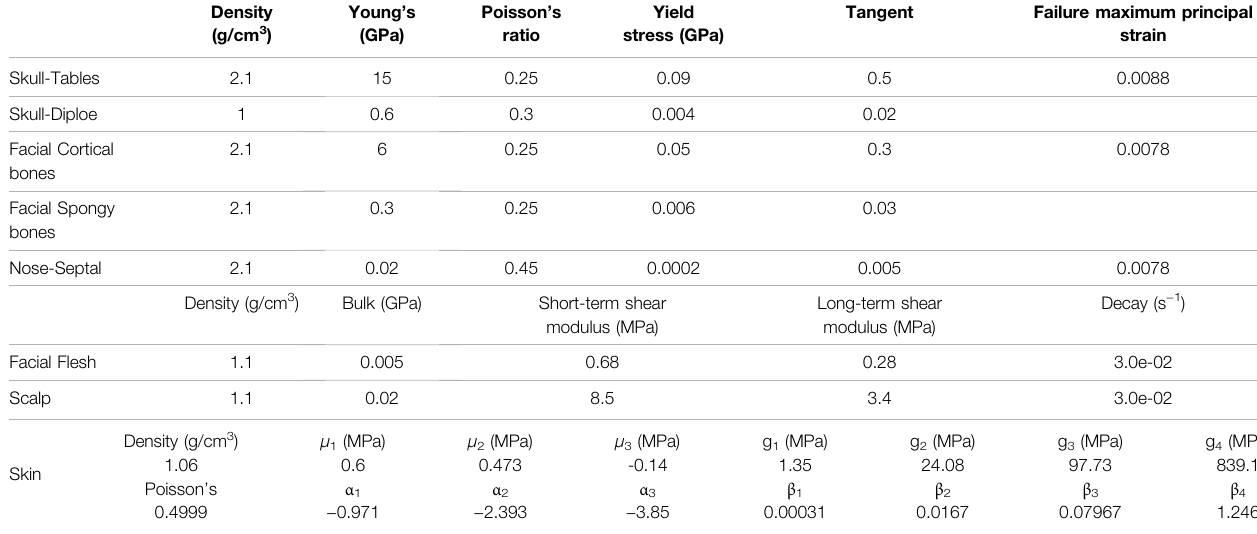
TABLE 2 | Material properties of the extracranial contents of the head model.